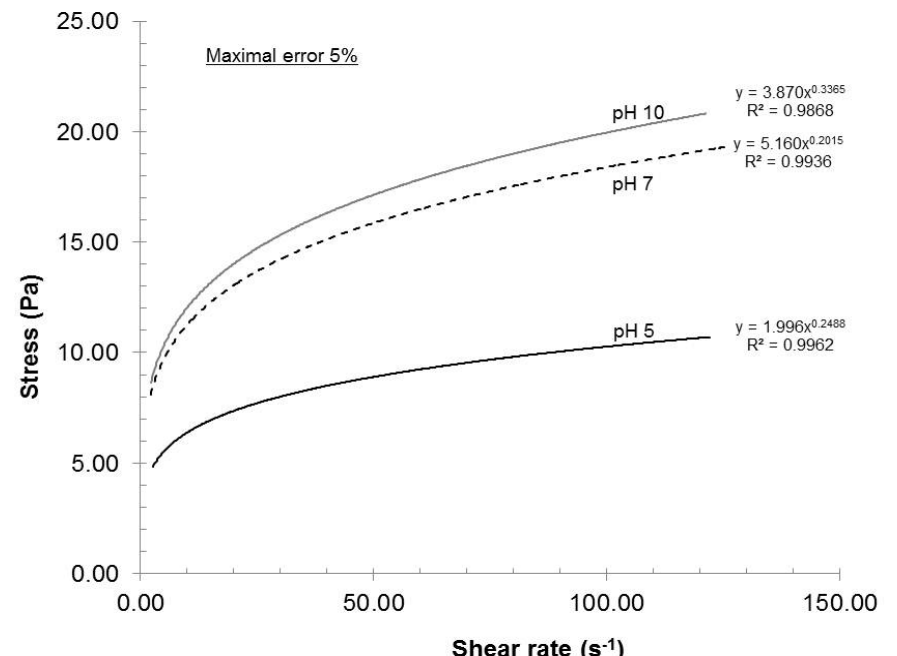
Figure 7. Effect of dispersion pH on the rheological evolution of the